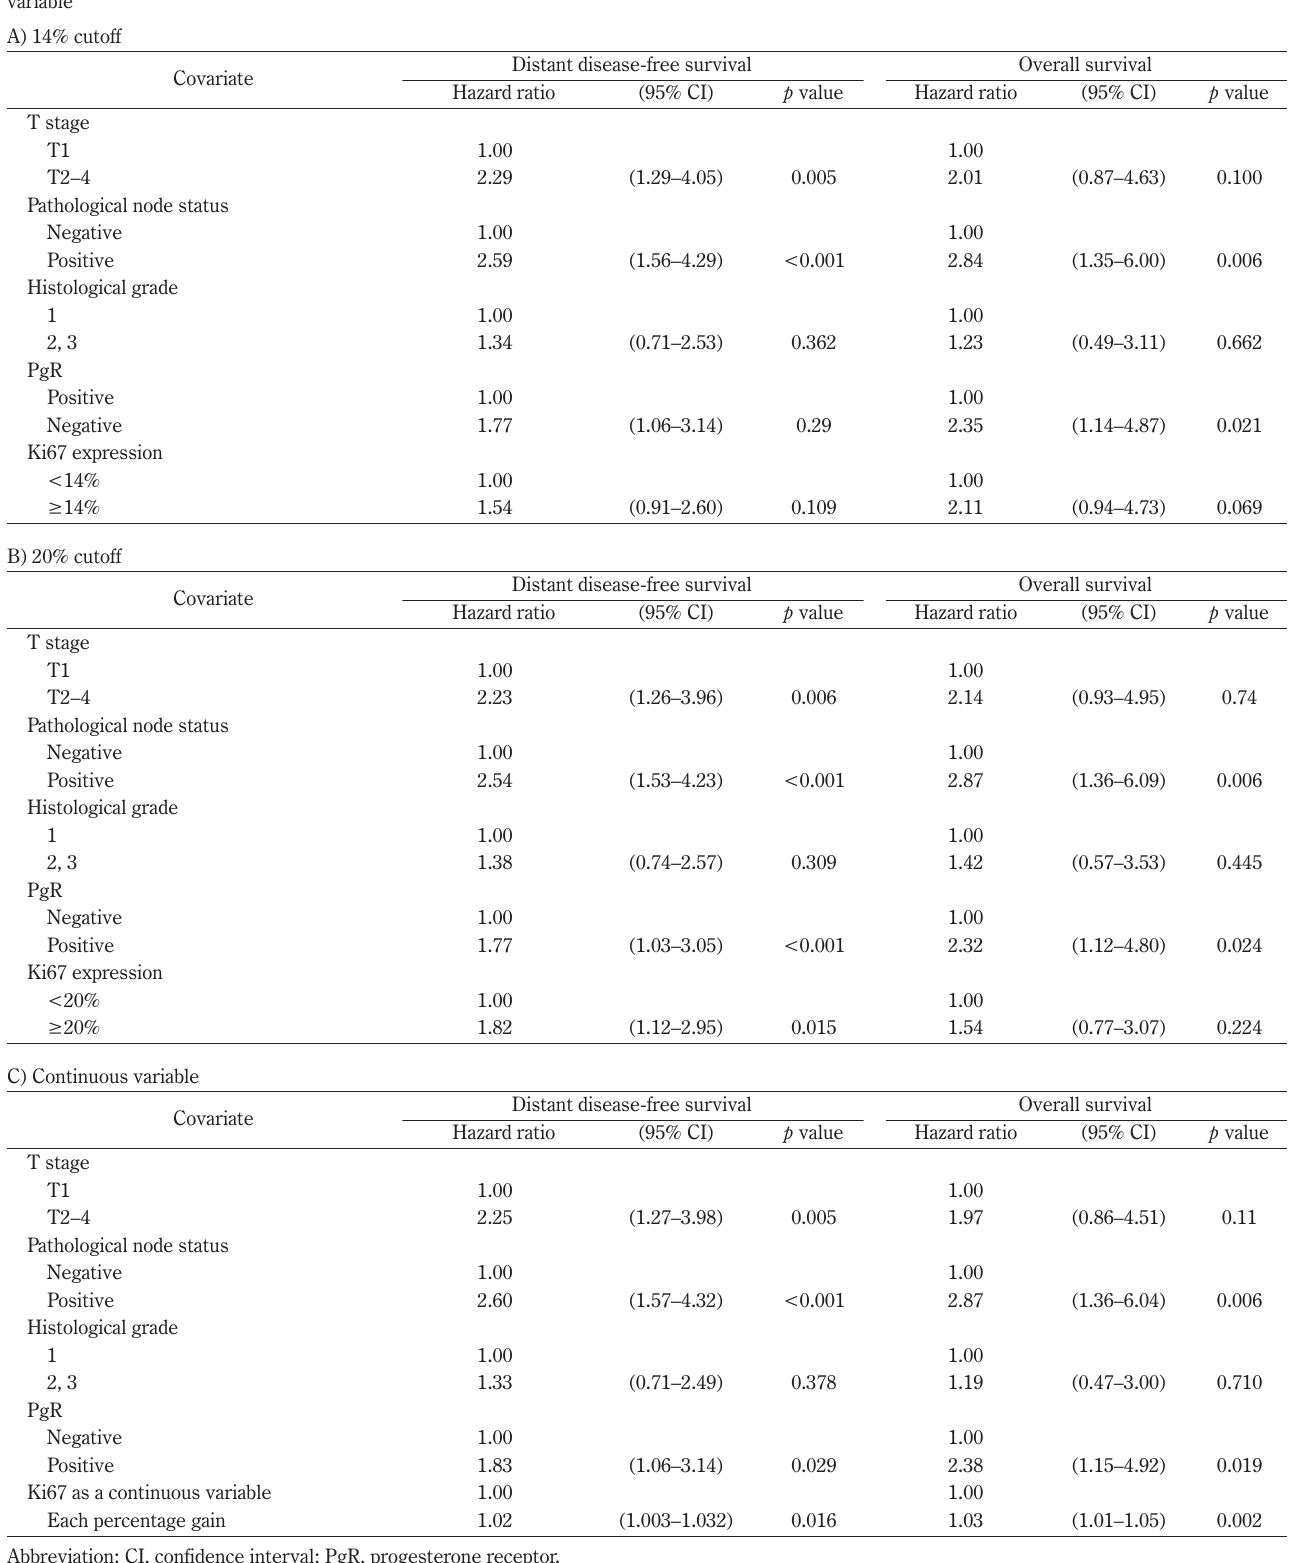
Table 3 Multivariate Cox analysis of distant disease-free survival and overall survival by Ki67 expression level at two cutoff values or as a continuous